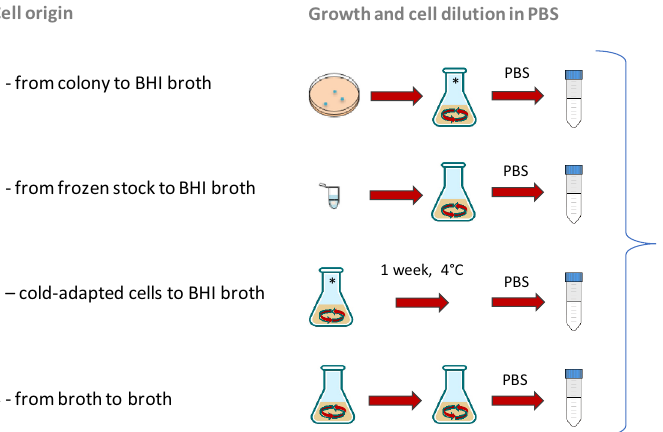
Figure 1. Schematic representation of four cell origin used in this study. Origin 1: from single colony to BHI broth; origin 2: from frozen stock to BHI broth; origin 3: cells derived from the condition 1 and then cold- adapted (1 week at 4 °C); origin 4: from culture in early stationary phase to BHI